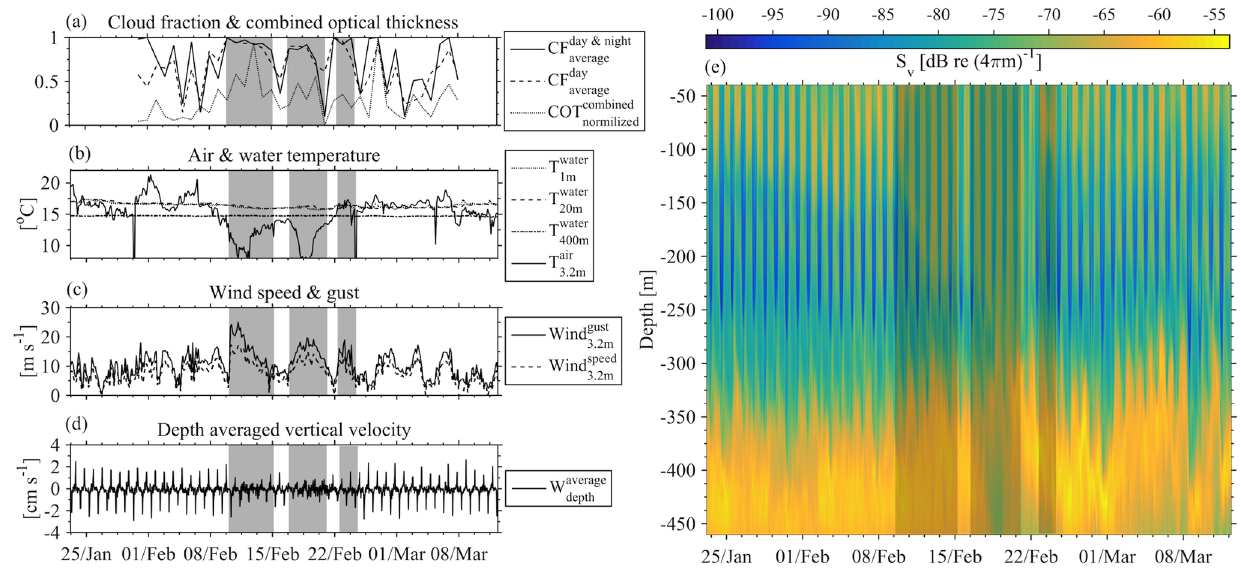
Figure 12. Cloudiness (a) , air and water temperature (b) and wind conditions (c) were examined in comparison to depth-averaged vertical velocities (d) and backscatter coefficient (e) during February 2015. Grey shaded areas denote the three harsh weather events referred to in the